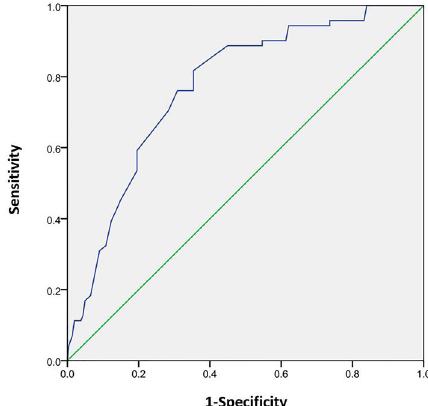
Figure 1. ROC curve was conducted to verify the association of non-high-density lipoprotein cholesterol level with the presence of cognitive dysfunction in acute ischemic stroke